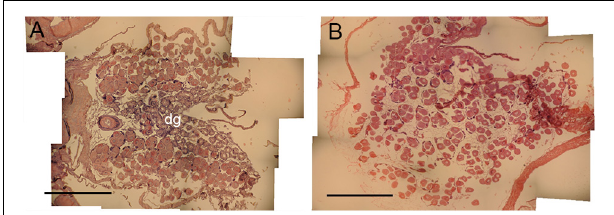
FIGURE 3 | Oocyte development in Bathyarca glacialis from the Barents Sea. Transverse histology sections show (A) reproductive organs and oocytes infiltrating the digestive diverticula under ambient environmental conditions and (B) oocyte development under representative future environmental conditions. dg, digestive diverticula. Scale bars = 1 mm.